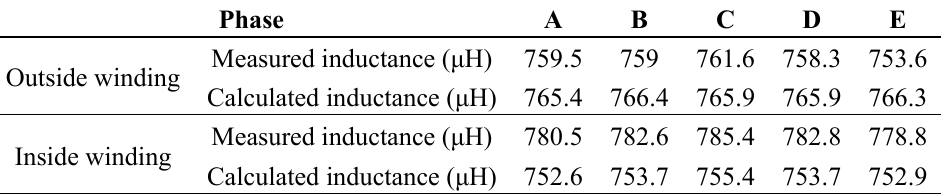
Table 9. The measured and calculated phase inductance of